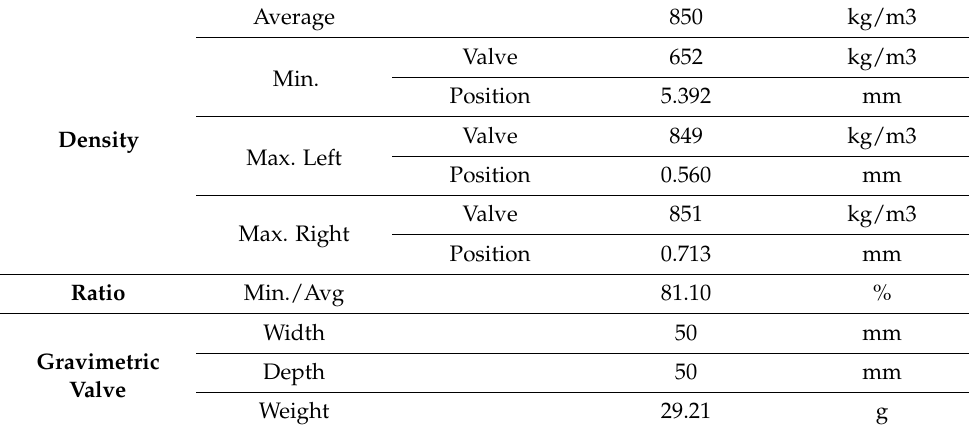
Table 9. Bending tests. Table 7. Experimental data of 1st sample.